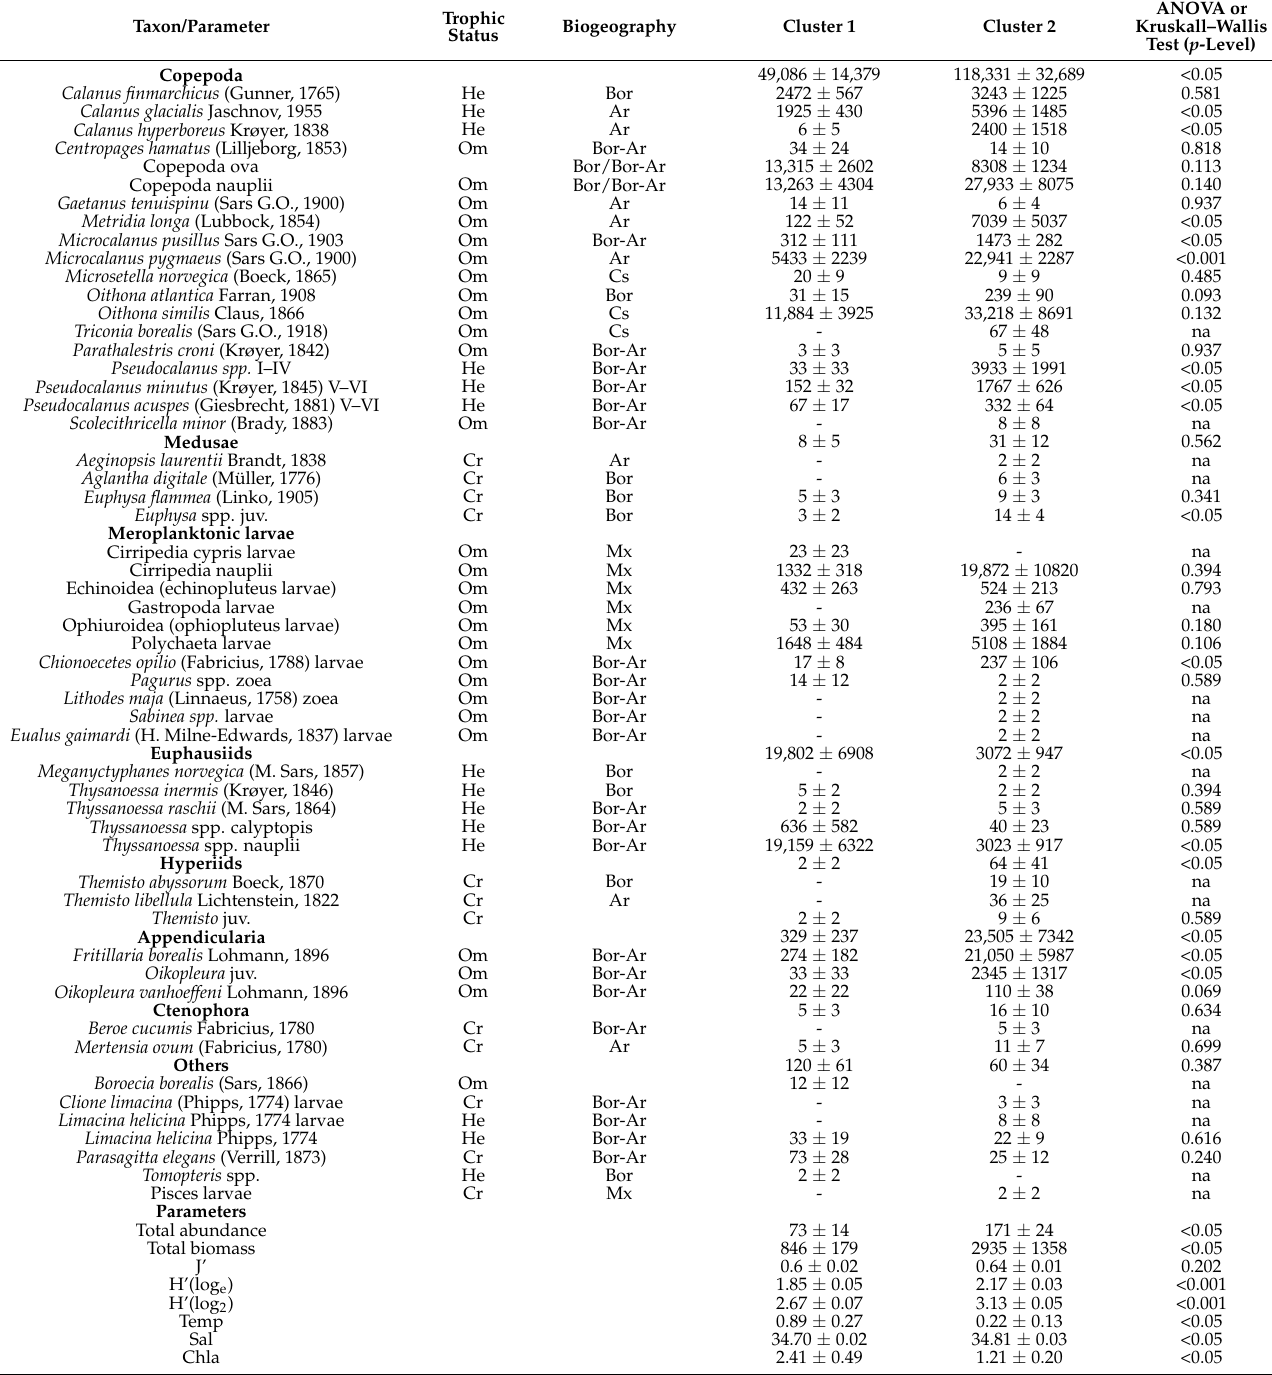
Table 2. Mean (individuals m –2 with standard error) abundance of mesozooplankton taxa; evenness (J); diversity (H’, Shannon index); total mesozooplankton abundance (10 3 individuals m –2 ); total mesozooplankton biomass (mg dry mass m –2 ); environmental parameters (Temp—mean temperature, ◦ C; Sal—mean salinity; Chla—mean chlorophyll a concentration, mg m –3 ) in each group defined by cluster analysis and results of comparisons between groups (simple ANOVA or Kruskal–Wallis